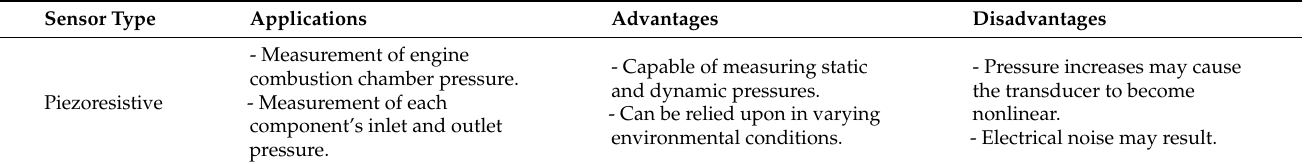
Table 24. Pressure